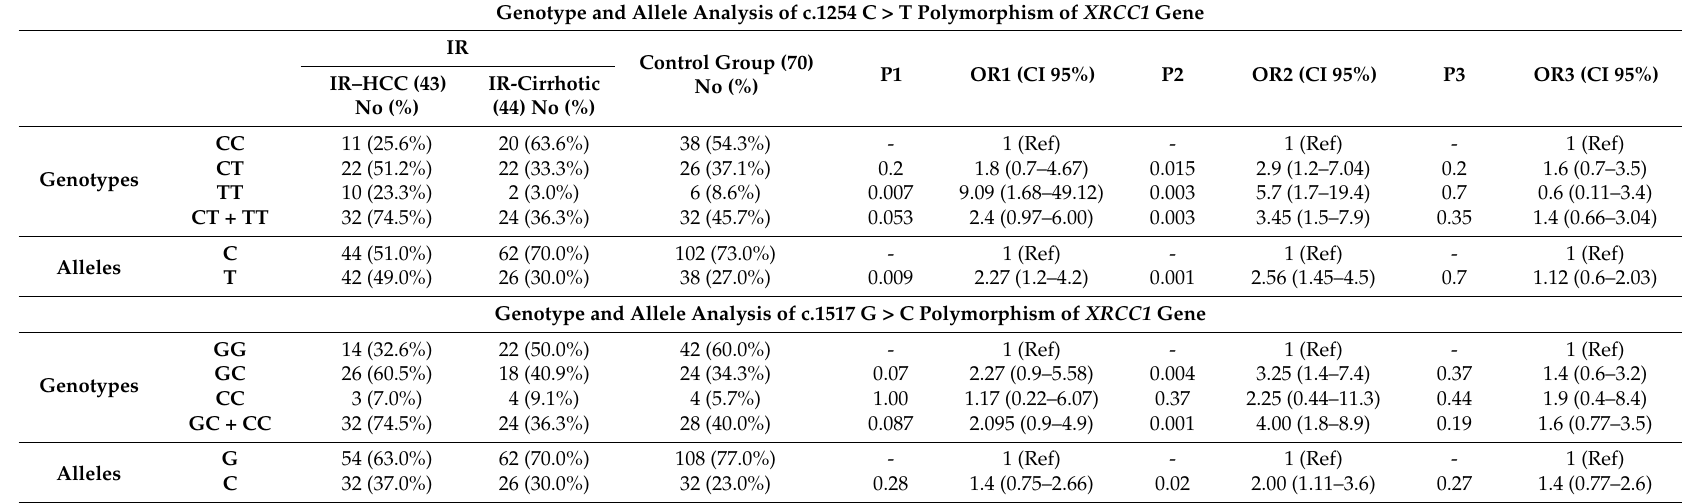
Table 3. Genotype and allele analysis of XRCC1 gene in IR-cirrhotic and IR-HCC and control groups. Genotype and Allele Analysis of c.1254 C > T Polymorphism of XRCC1 Gene